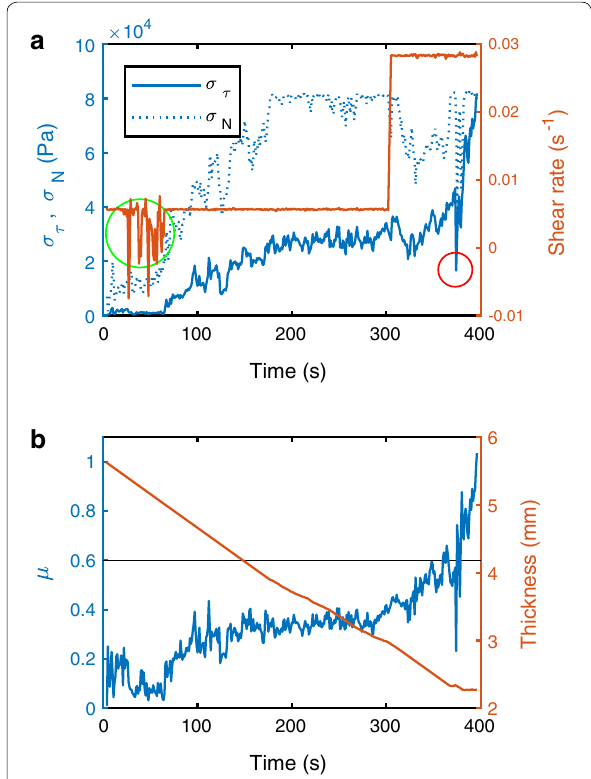
Fig. 7 Friction coefficient and fracturing of a scoria. a Shear (solid curve) and normal (dotted curve) stresses to deform Sample 3 measured under one-directional rotation with two shear rates (red curve) at T = 500 ◦ C . b Friction coefficient µ = σ τ /σ N and the thickness of the sample